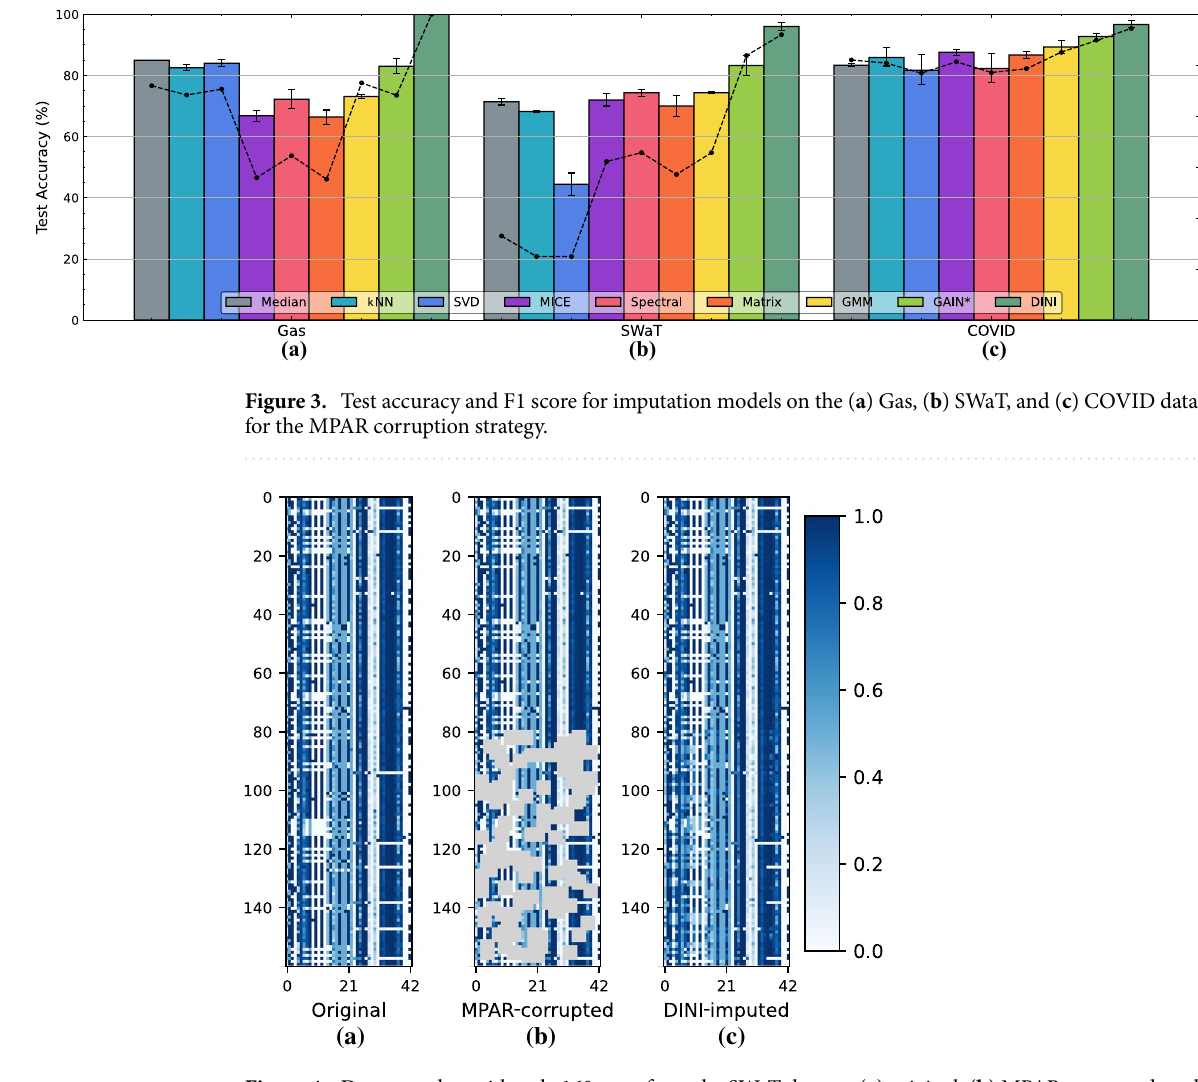
Figure 4. Data snapshot with only 160 rows from the SWaT dataset: ( a ) original, ( b ) MPAR-corrupted, and ( c ) DINI-imputed. 50% correct (0–79) and 50% corrupted (80–159; with a high corruption ratio) data form the training set for the imputation